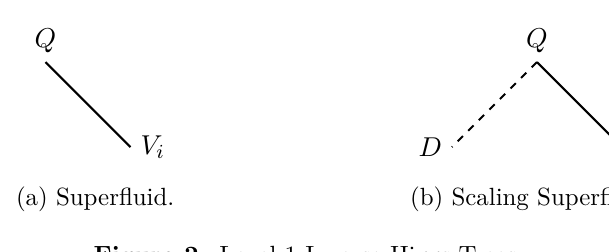
Figure 2. Level-1 Inverse Higgs